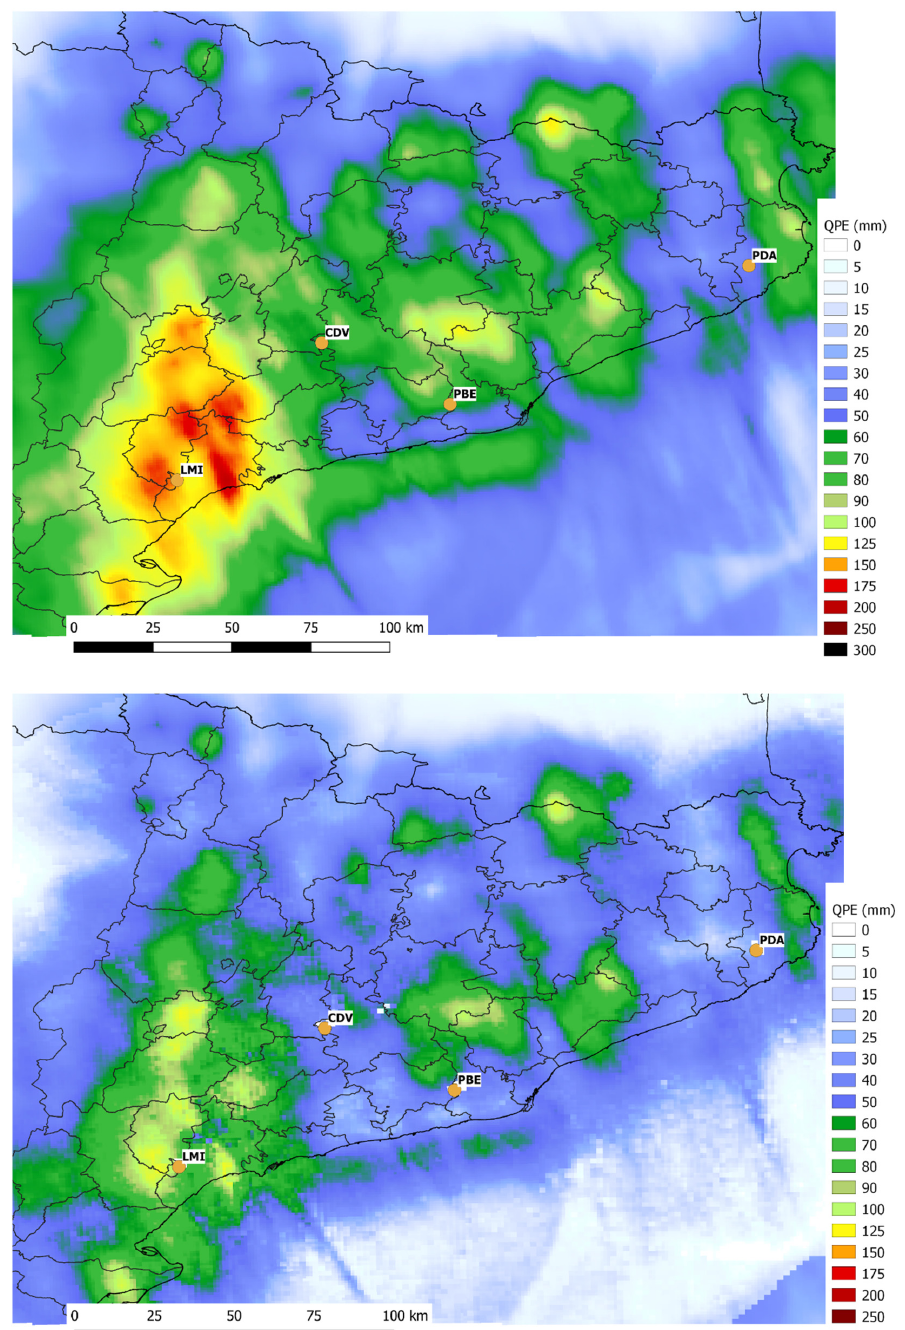
Figure 9. Top : QPE with EHIMI corrections combined with rain gauge data for the 22 October 2019 event. Bottom : Difference in the QPE 3 field with respect to the uncorrected one, QPE 1 (Figure 7).